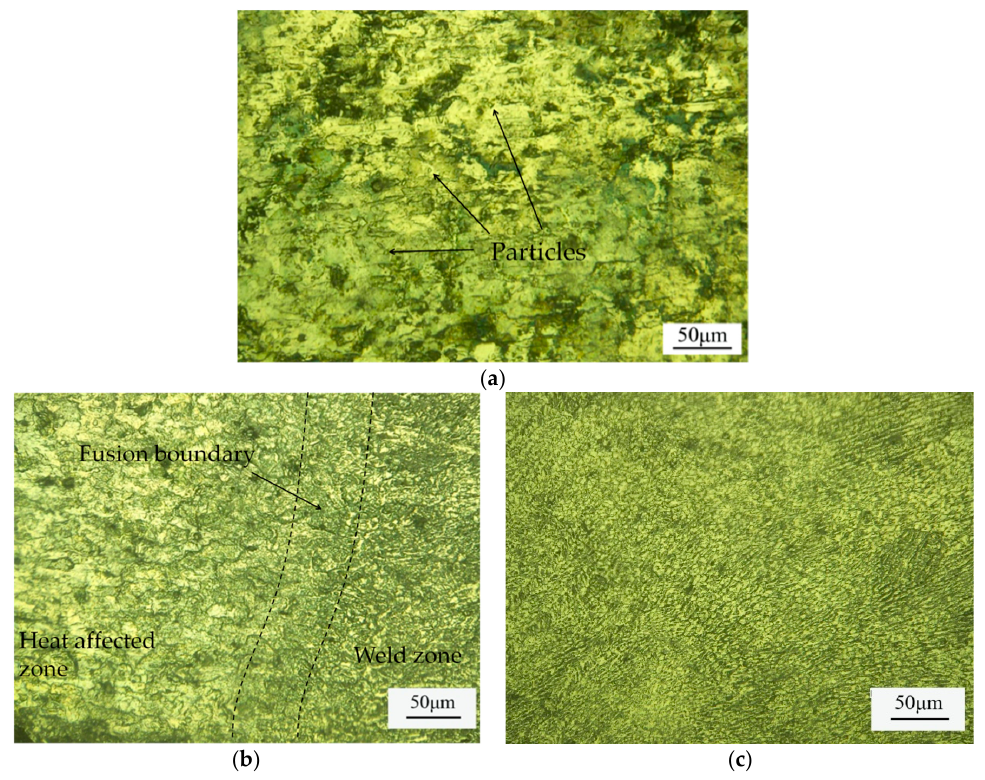
Figure 9. Metallographic structure of base metal and weld cross section. ( a ) Base metal; ( b ) Heat affected zone; ( c ) Weld zone.